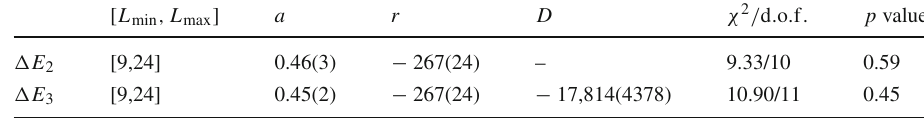
Table 1 Selected fit results to (cid:7) E 2 ,